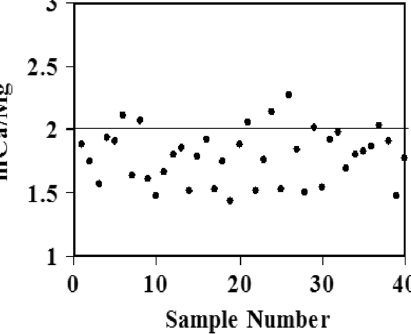
Fig. 4 The scatter diagram of Ca 2 - versus HCO 32 - around 1:2 line indicates that carbonic acid is the agent in the weathering of